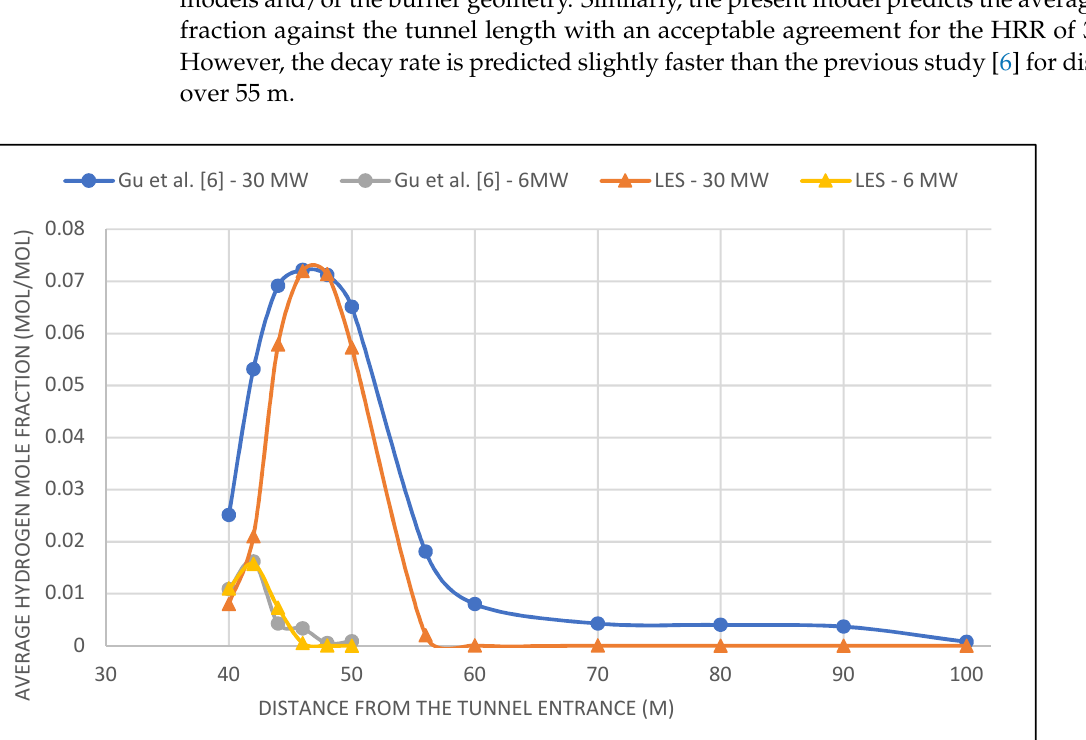
Figure 4. Hydrogen mole fraction along the tunnel—validation case.